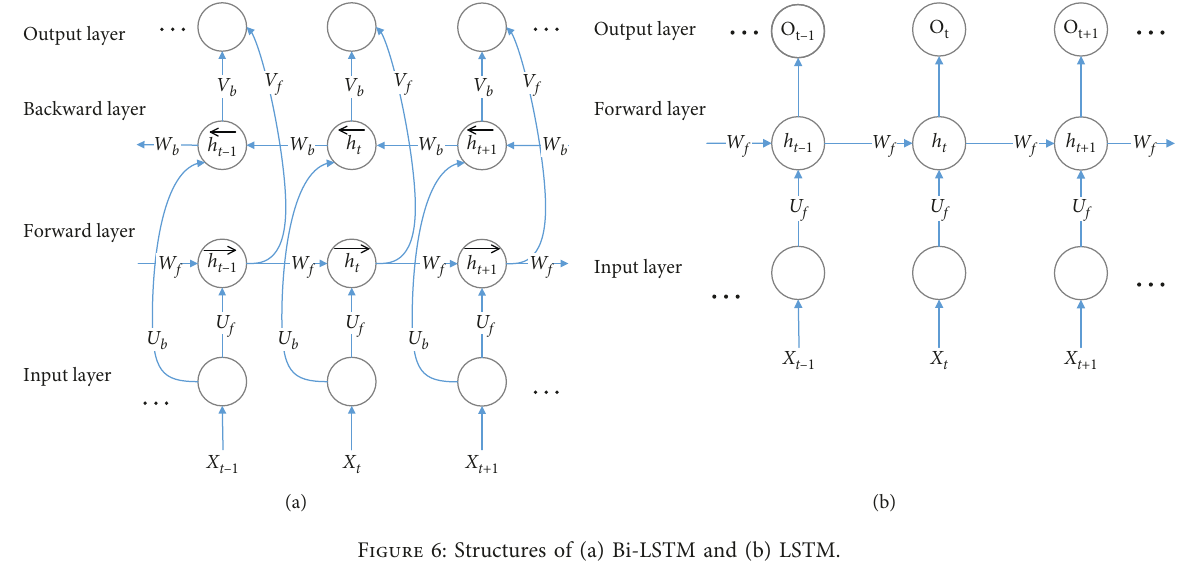
Figure 6: Structures of (a) Bi-LSTM and (b) LSTM.